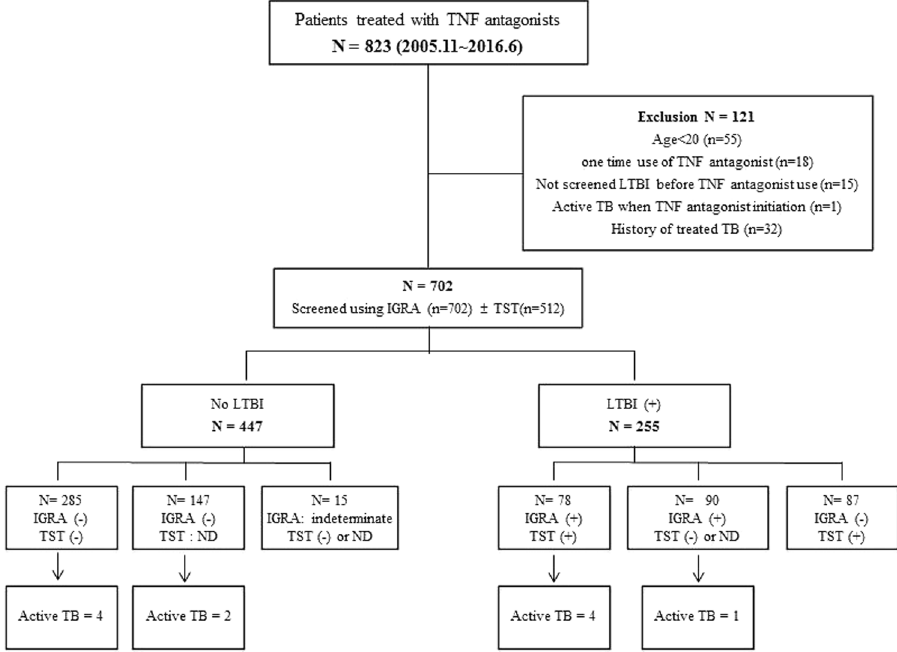
Figure 1. LTBI screening and active TB development in patients treated with TNF antagonists. TNF, tumor necrosis factor; TB, tuberculosis; LTBI, latent tuberculosis infection; IGRA, interferon-gamma release assay; TST, tuberculin skin test; ND, not